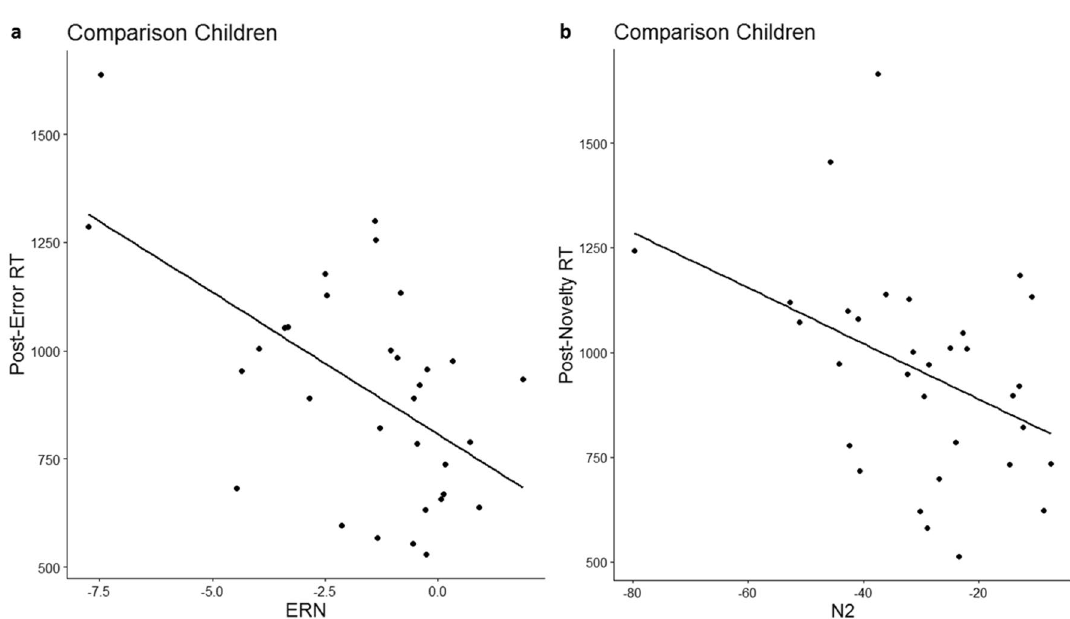
Figure 6. ( a ) Stronger ERN was significantly correlated with increased post-error reaction times (increased PES); ( b ) Stronger N2 (more negative N2 amplitude) was marginally associated with increased post-novelty reaction times (increased PNS) for children in the comparison